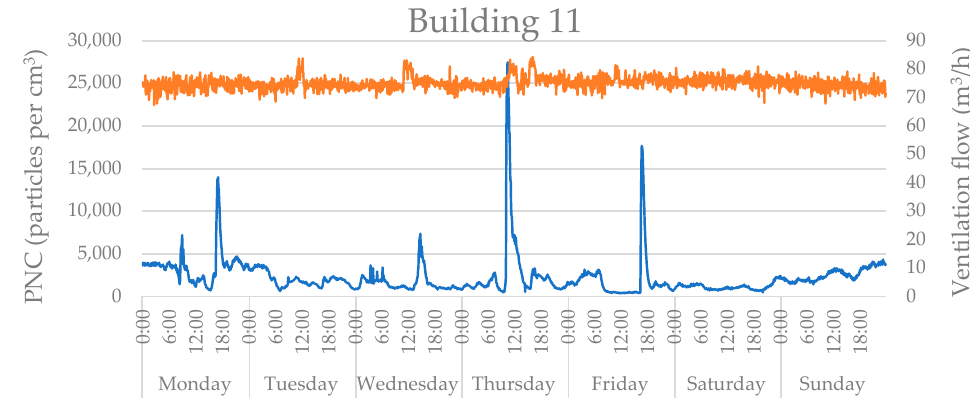
Figure 10. The NP number concentration (blue line) and the ventilation flow (orange line) in Building 11 during the heating season. The NP concentrations and the ventilation flow were measured in five-minute intervals.